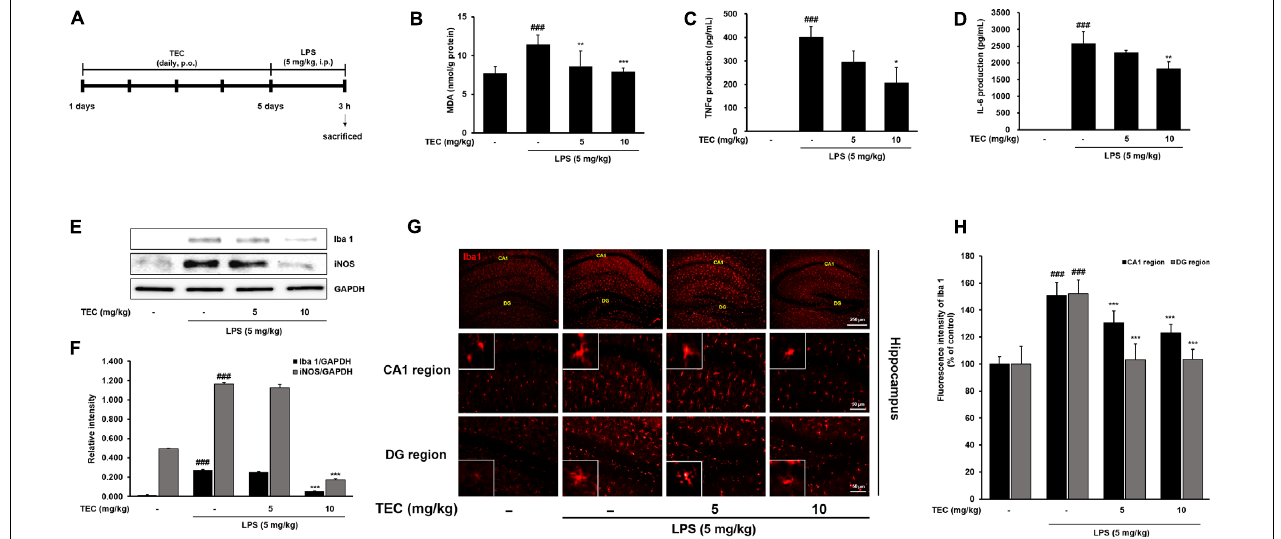
FIGURE 6 | TEC inhibits neuroinflammation in LPS-stimulated mice. (A) Mice were assigned to four groups ( n = 7/group) and administered vehicle (saline) or TEC at doses of 5 or 10 mg/kg orally for 5 days after adaptation for 1 week. On day 5, LPS (5 mg/kg) were administered 3 h before the sacrificed. (B) MDA levels were measured in hippocampus of the mouse model. (C,D) Production of TNF- α (C) and IL-6 (D) in the serum were measured using ELISA. (E) The expression of Iba1 and iNOS was detected by western blotting using specific antibodies in murin hippocampus tissues. GAPDH protein was used as an internal control. (F) Bar graphs represent the relative expression of Iba1 and iNOS for (E) . (G) Immunoreactive cells of anti-Iba1 antibody was investigated two different region (CA1; cornu ammonis 1 and DG; dentate gyrus) in the brain hippocampus by immunofluorescence analysis. (H) Bar graphs represent the fluorescence intensity of Iba1 for (G) .